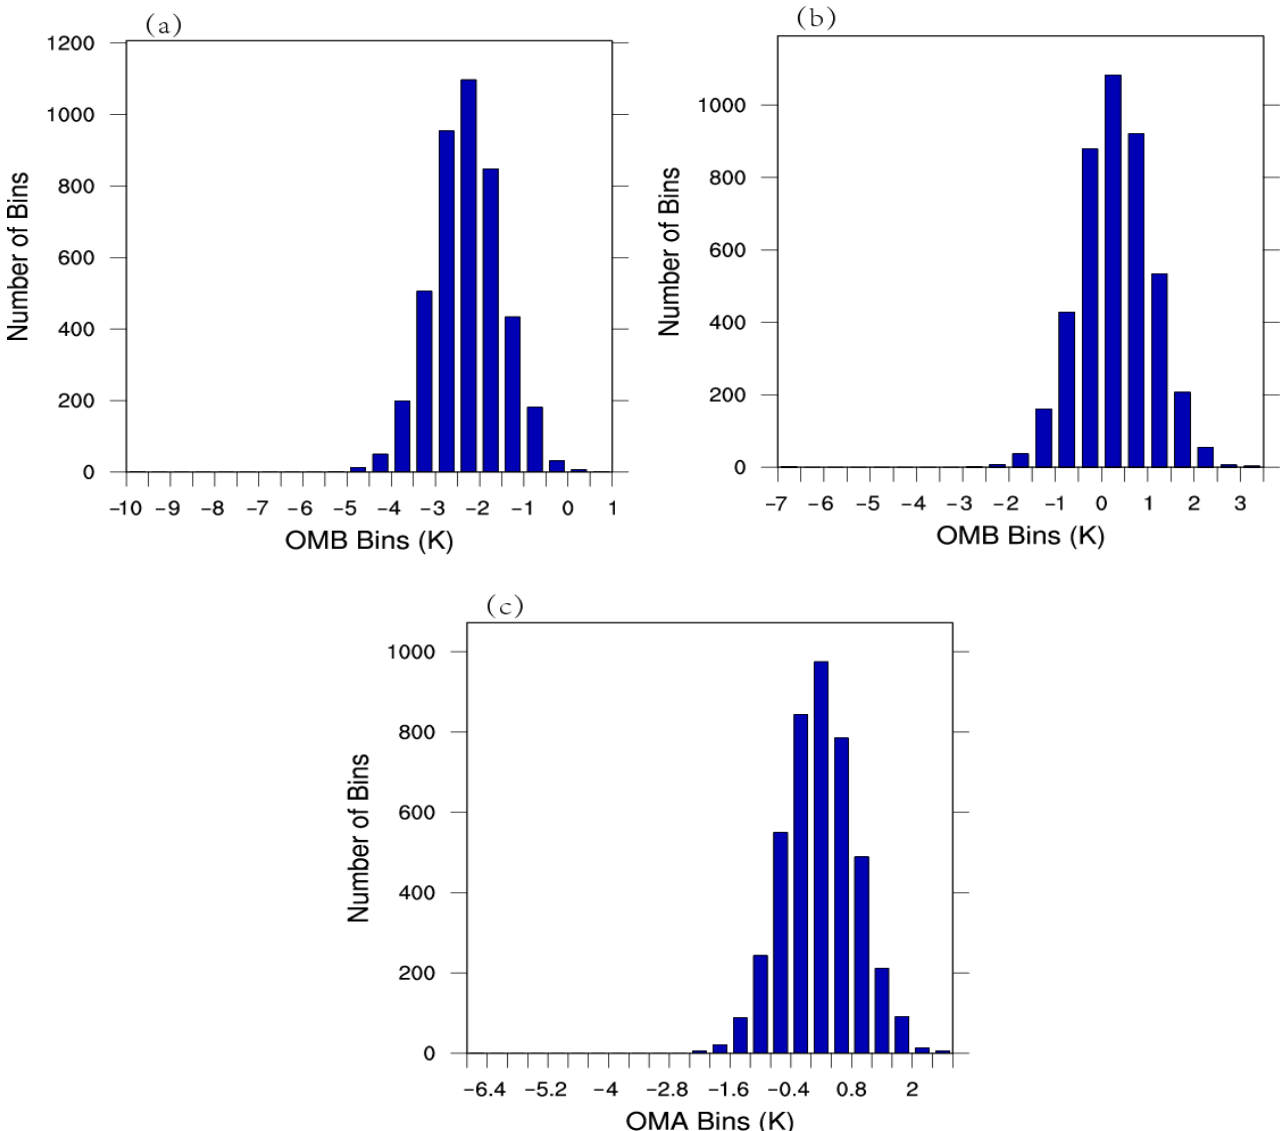
Figure 6. The frequency distribution histogram of ( a ) OMB without bias correction, ( b ) OMB with bias correction, and ( c ) OMA with bias correction of channel 5.